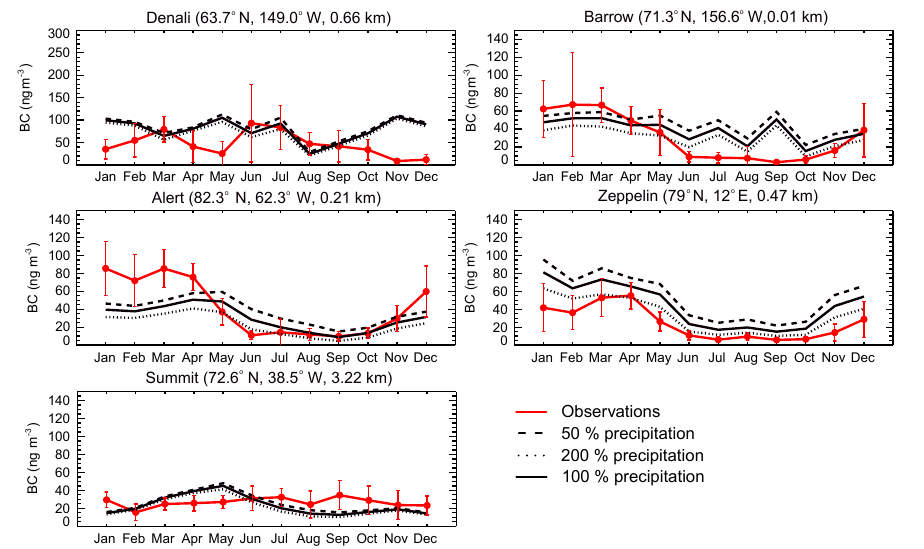
Figure 8. Same as Fig. 5, but for Exp. D with standard precipitation (solid black), 50% precipitation (dashed black), and 200% precipitation (dotted black). See text for